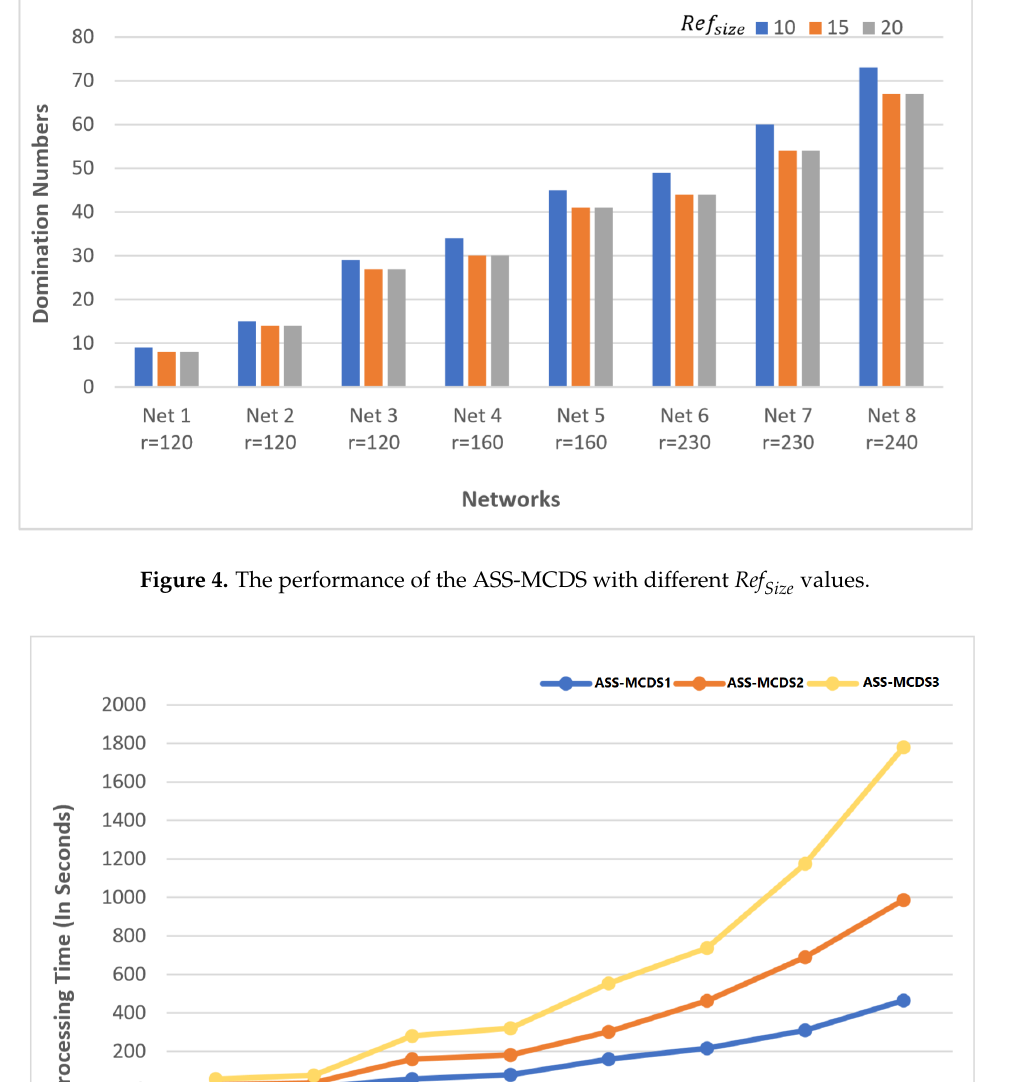
Figure 5. The average processing time of the ASS-MCDS with different Ref